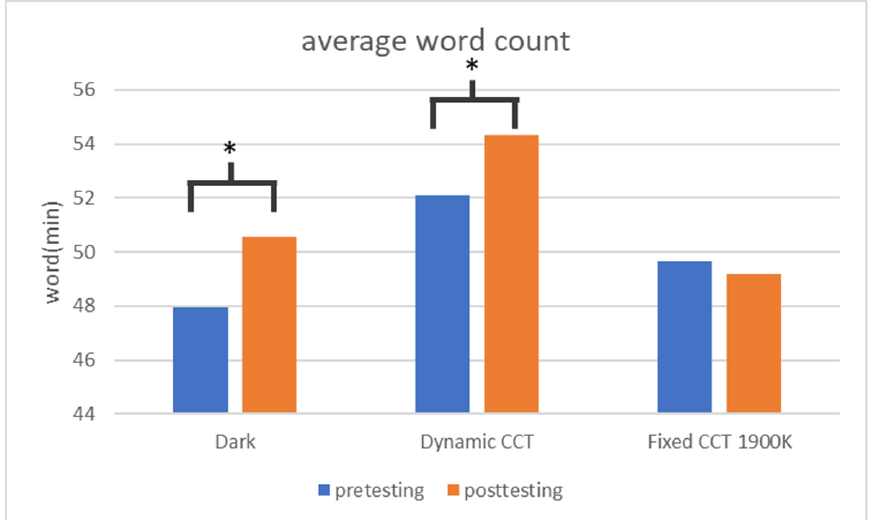
Figure 27. Typing test average word count analysis (* p < 0.05).